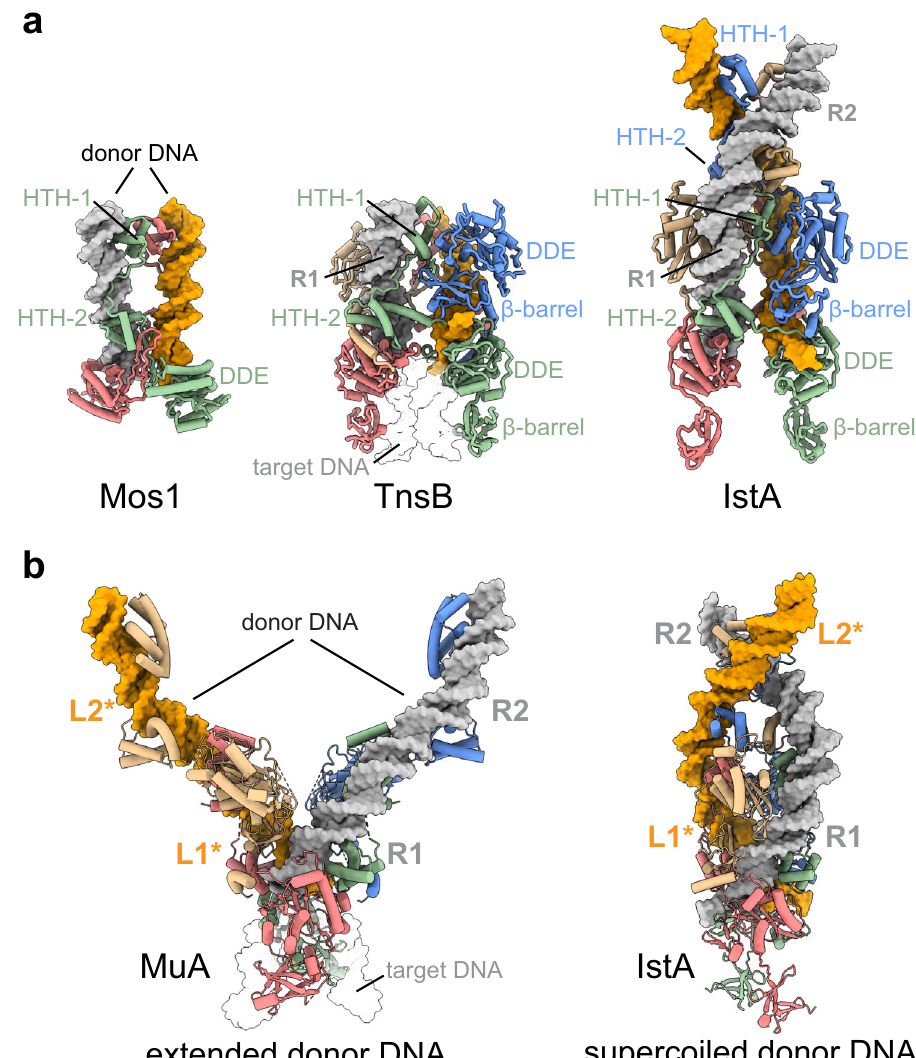
Fig. 7 | Comparison between IstA, Mos1, TnsB and MuA transposases. a Similar views of Mos1 (PDB ID 3HOS [https://doi.org/10.2210/pdb3HOS/pdb]), TnsB (PDB ID 8AA5 [https://doi.org/10.2210/pdb8AA5/pdb]) and IstA (from the two highly- similar TnsB tetrameric structures, the one obtained at higher resolution has been usedtoperformthestructuralcomparisons).Eachtransposasemonomerhasbeen coloreddifferently.DonorDNAmonomerscoloredinorangeandgrey.TnsBtarget